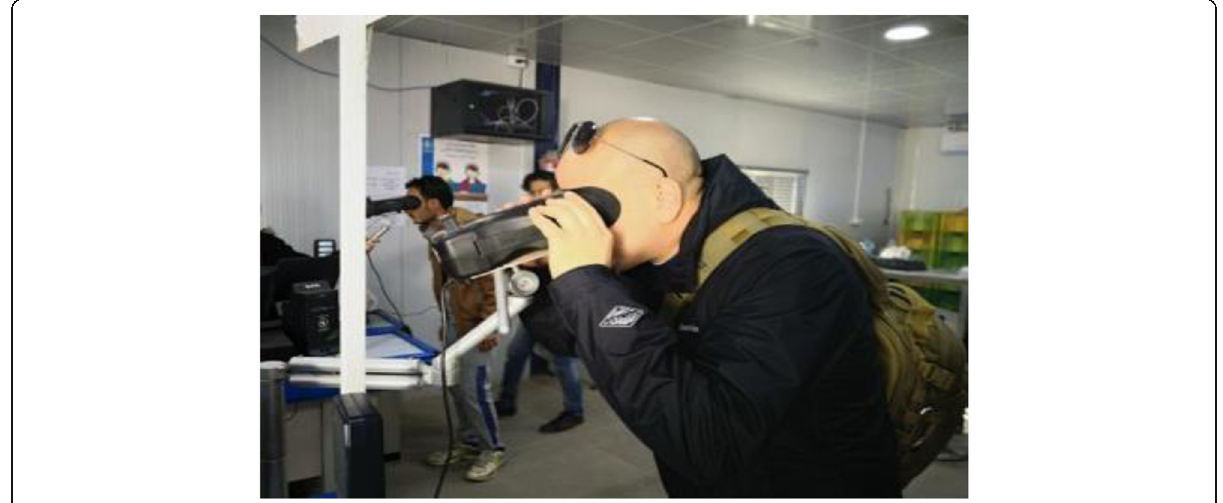
Fig. 1 Retinal recognition system in use in a food distribution centre, Azraq refugee camp, Jordan (photo: